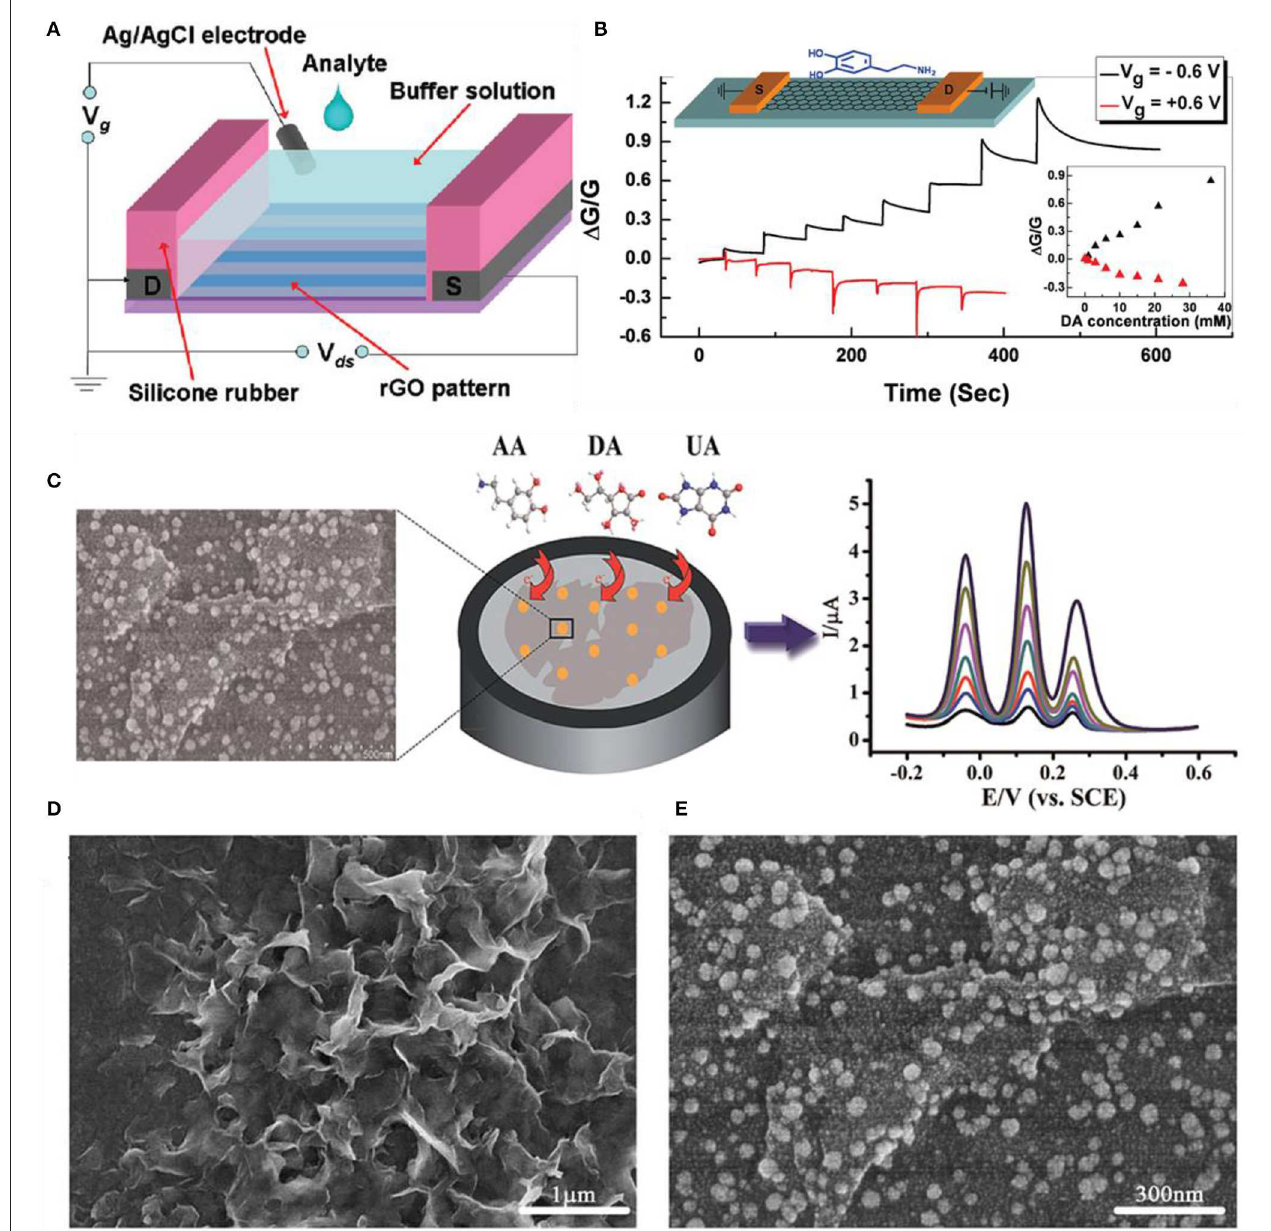
FIGURE 9 | Dopamine, uric acid, and ascorbic acid sensors using 2D materials. (A) Schematic figure of RGO FET for dopamine sensing. (B) Detection curves of RGO FET at V g = 0.6V; each step indicates the gradual addition of dopamine ranging from 1 to 8mM. Figures (A,B) were reproduced from He et al. (2010) with permission from the American Chemical Society. (C) Schematic illustrations of gold-decorated MoS 2 -based electrochemical sensors. (D) Scanning electron microscopy images